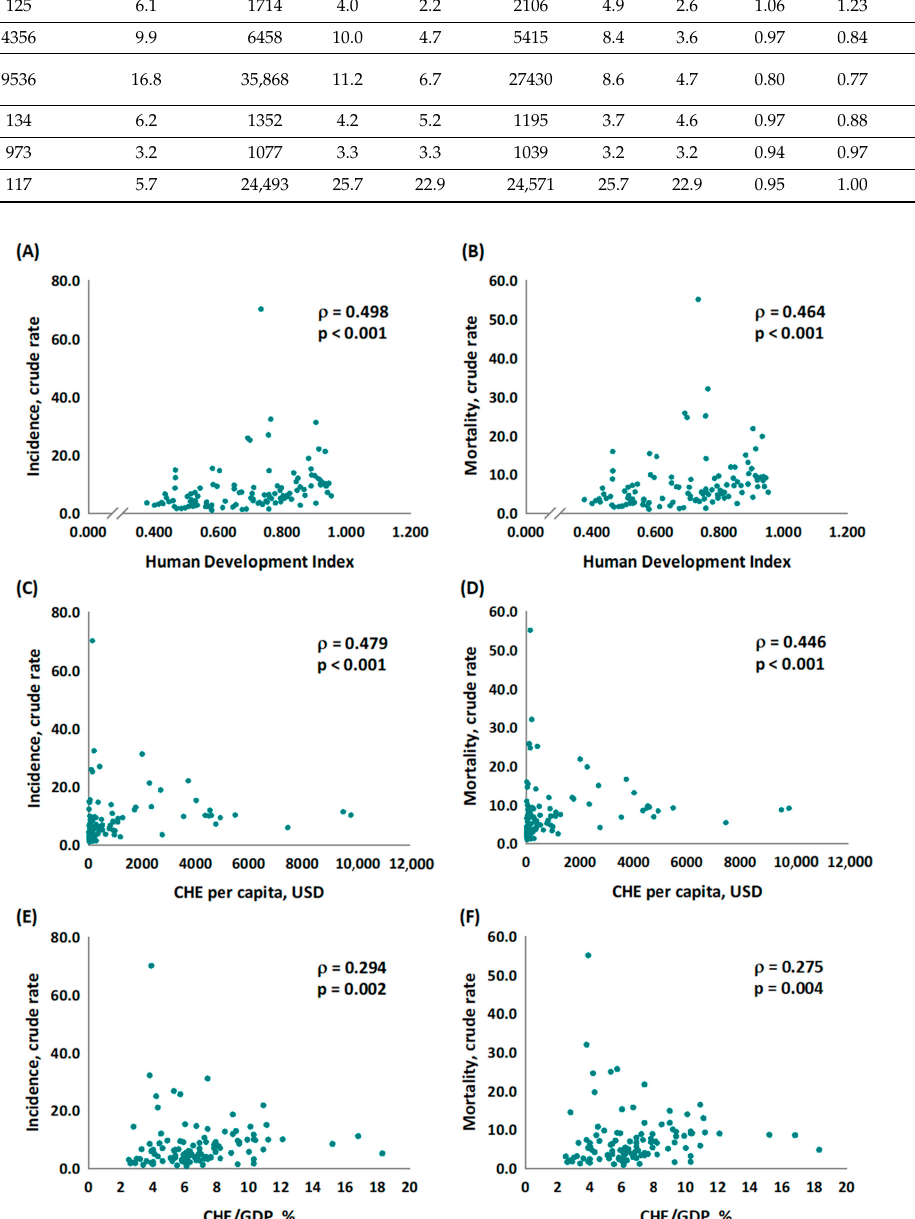
Figure 1. The association between human development index, current health expenditure, and the crude rates of ( A , C , E ) incidence and ( B , D , F ) mortality in liver cancer.